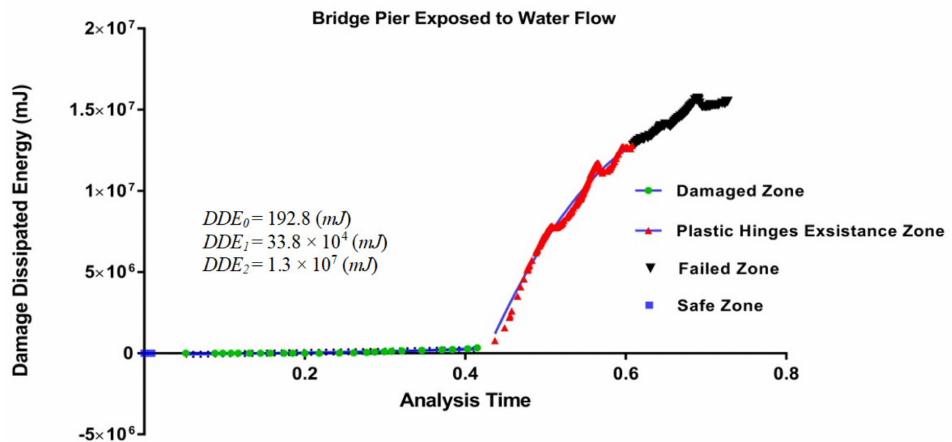
Figure 10. The variation in damage dissipated energy (DDE) for the entire pier model. Comparing Figures 7 and 10, an excellent correlation between the deformation and DDE change rate trend is observed during the increase of pressure in water flow. The analysis and plot of the change in dissipated energy versus water flow pressure are shown in Figure 11.